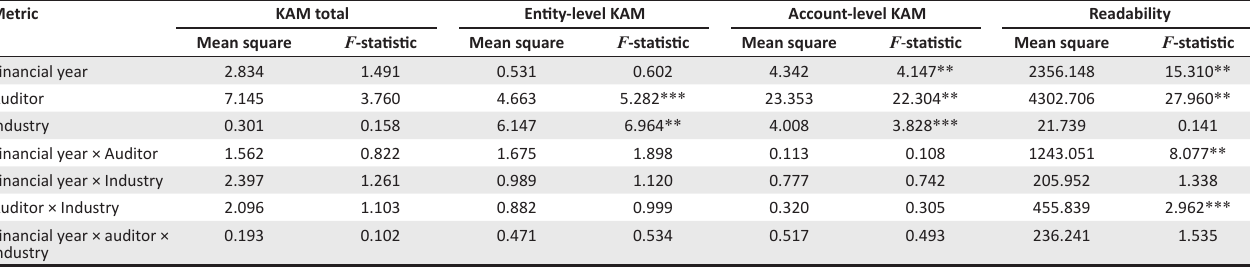
TABLE 4: Analysis of variance: financial year, audit firm and industry versus key audit matter measures.